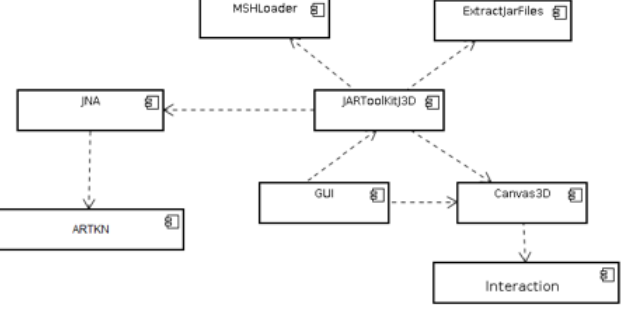
Fig. 1. GTRM Architecture.